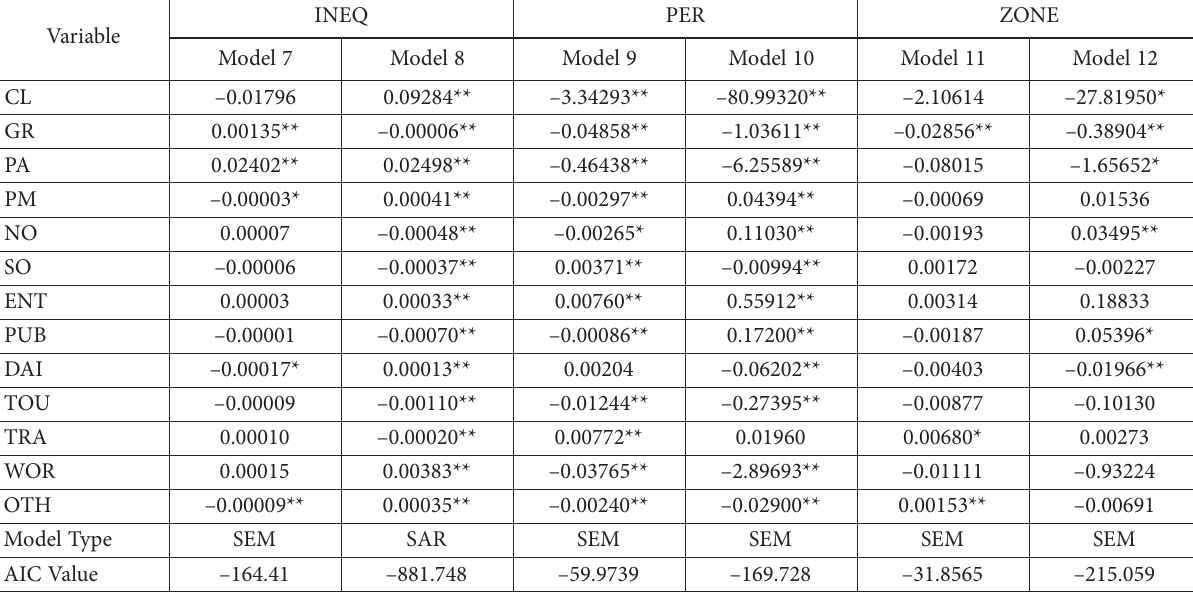
Table 6. Parameter estimation result of local regression models in regions with different economic levels